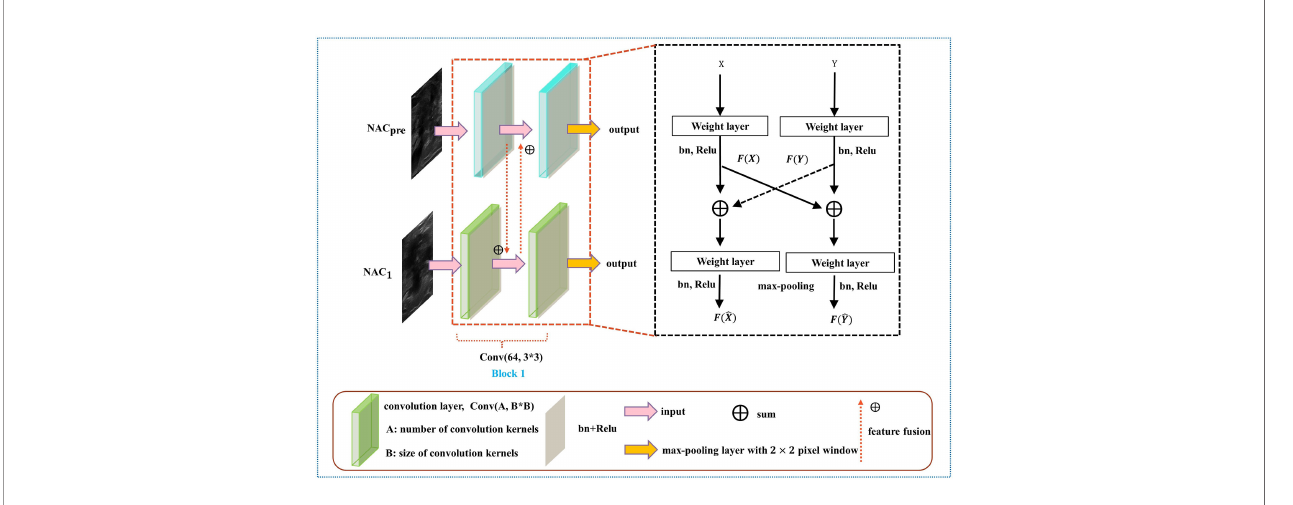
FIGURE 5 | Diagram of the feature-sharing